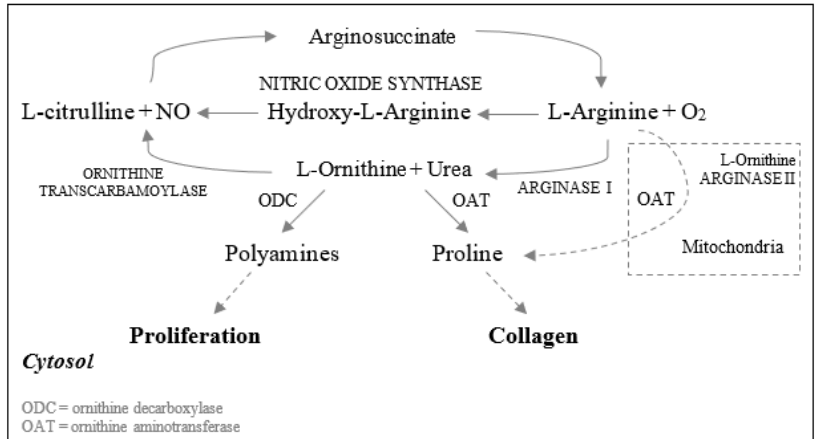
Figure 2. Metabolism of L-Arginine to produce NO and metabolites involved in the wound healing process. Arginine can be catabolized via the NO synthase pathway. Here, L-Arginine can be converted to L-ornithine and urea by arginase I. Then, by the action of ornithine aminotransferase, ornithine is transformed into proline, which is needed for collagen synthesis. L-ornithine can also be converted to polyamines, which are required for cell proliferation by ornithine decarboxylase [22]. There are two pathways in wound healing involving arginine (a) the arginase pathway, which produces polyamines, as well as ornithine and proline. Polyamines are needed for cell proliferation, while the latter ones are required for the synthesis of collagen; and (b)